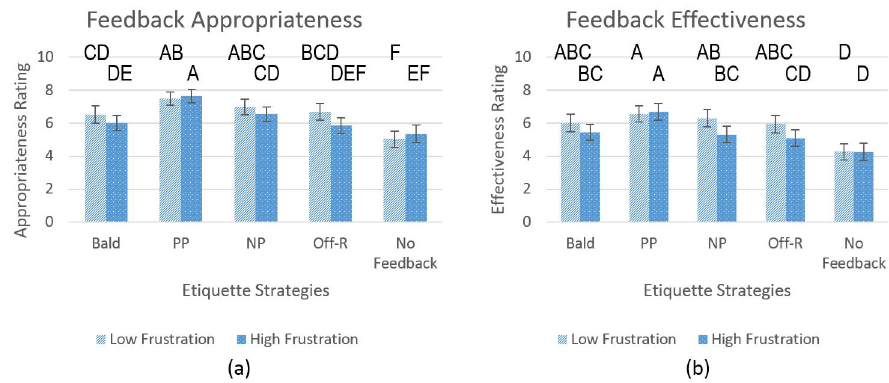
Figure 7. Mean and standard error of feedback ( a ) appropriateness and ( b ) effectiveness ( n = 40).